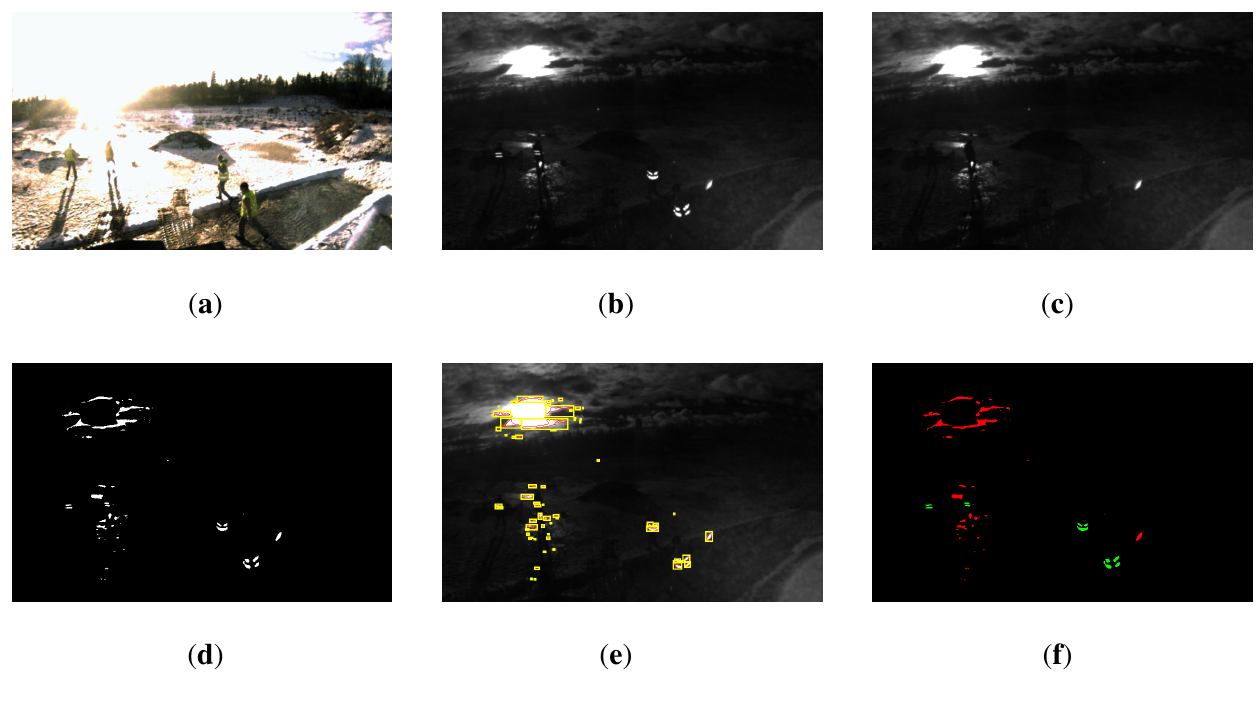
captured without flash. nf ; ( e ) Bounding boxes f . nf